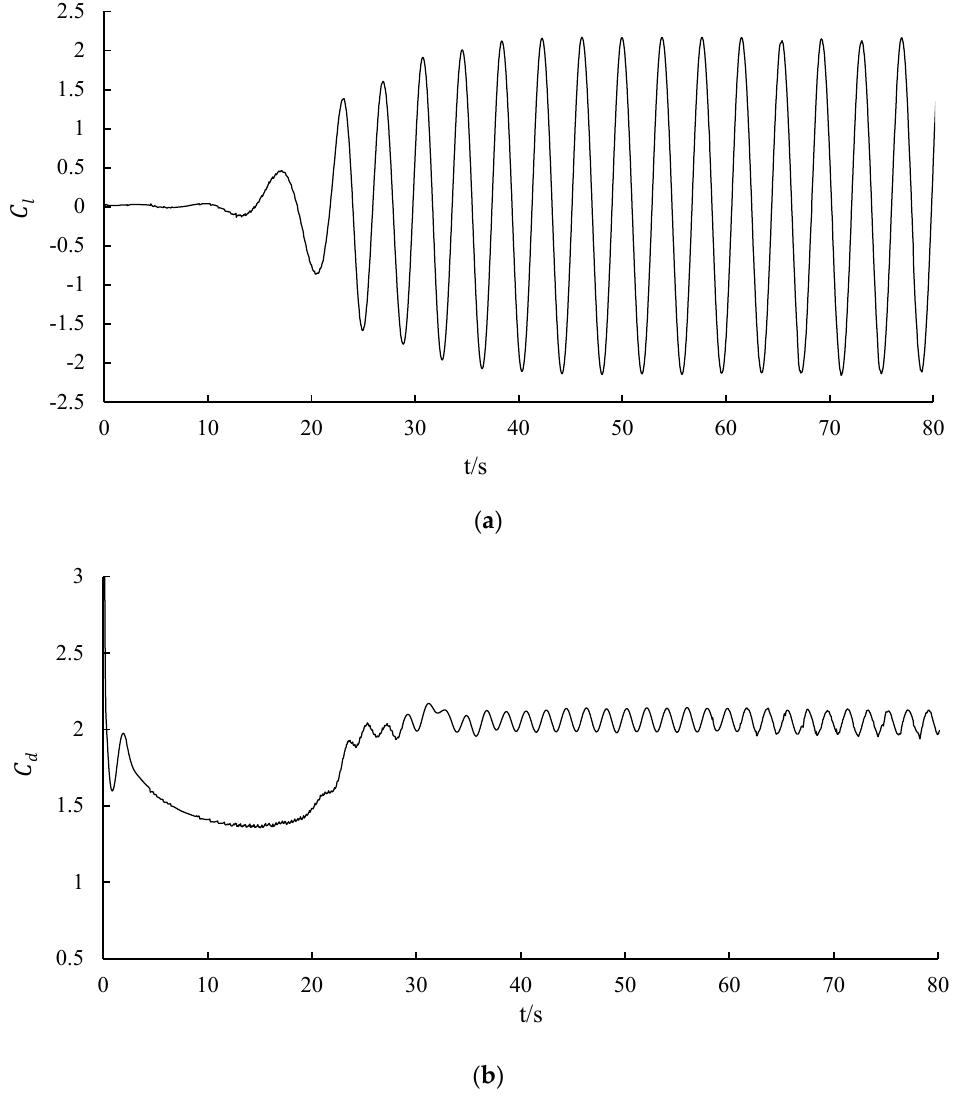
Figure 4. The lift and the drag coefficients of the flow over a square object. ( a ) The lift coefficient C l ; ( b ) the drag coefficient C d . Table 1. Comparison with the reference.